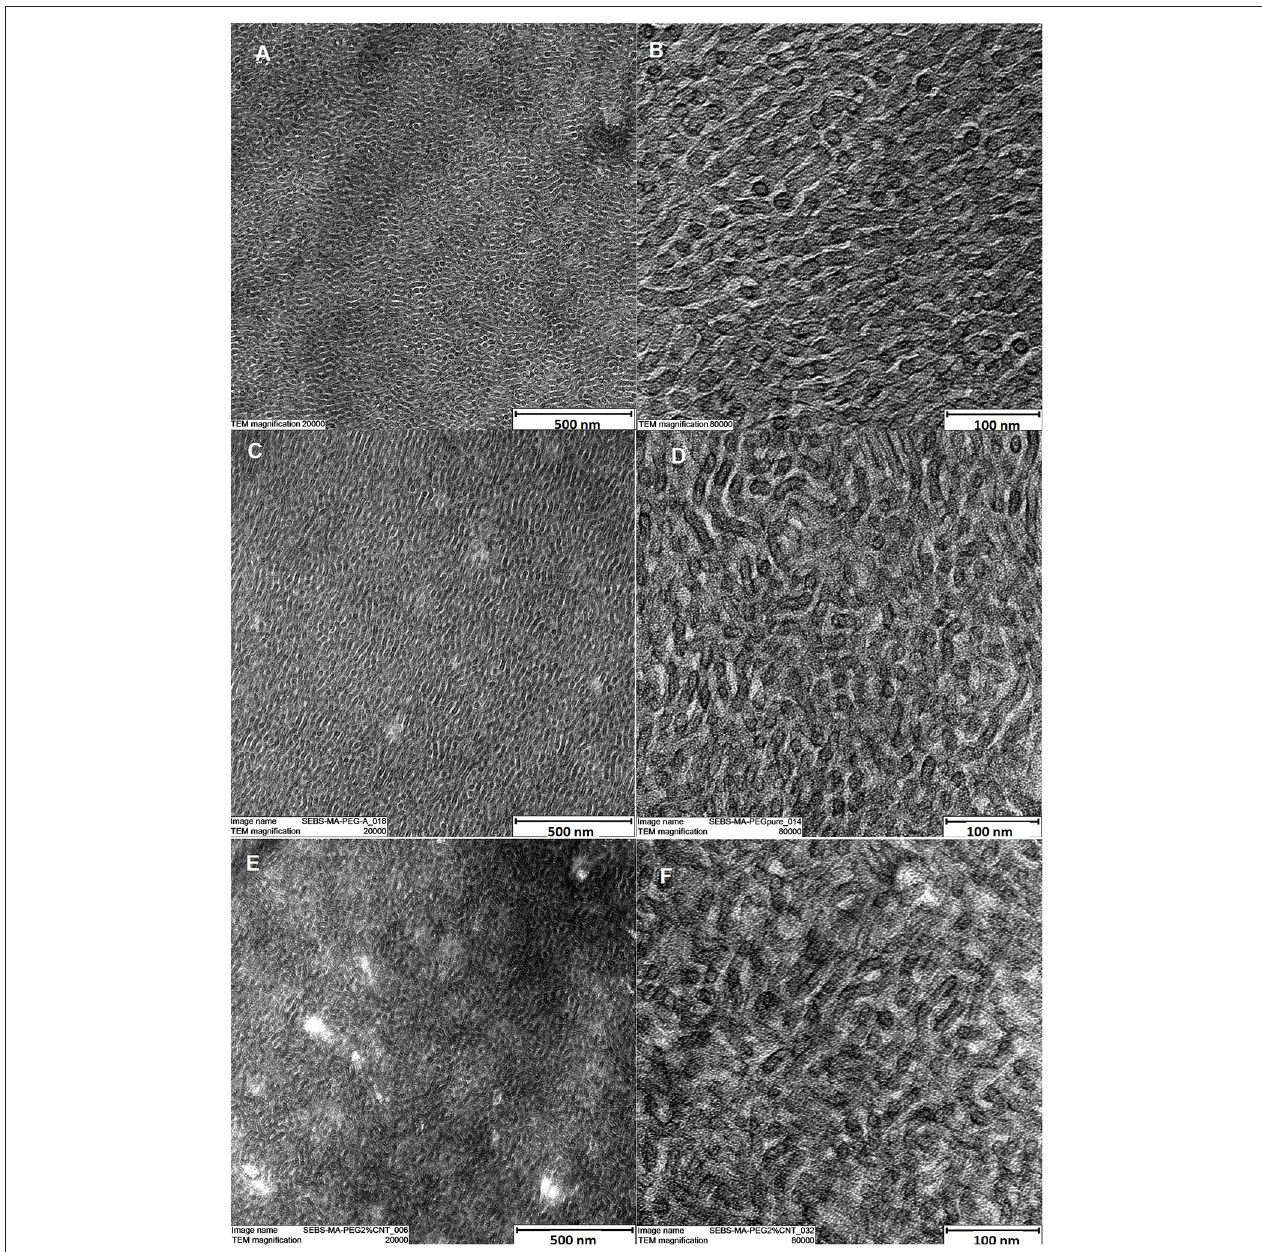
FIGURE 2 | TEM images of RuO 2 -stained samples of (A,B) SEBS-MA, (C,D) SEBS-MA-PEG, and (E,F) SEBS-MA-PEG/2MWCNT-P.